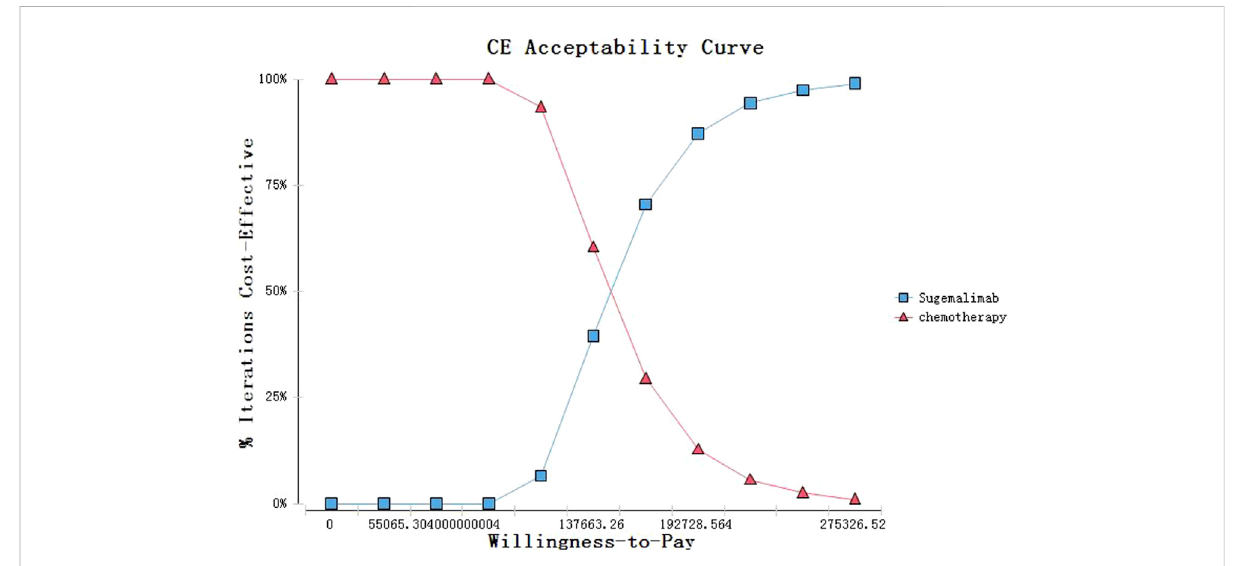
FIGURE 3 Cost-effectiveness acceptability curves of sugemalimab vs